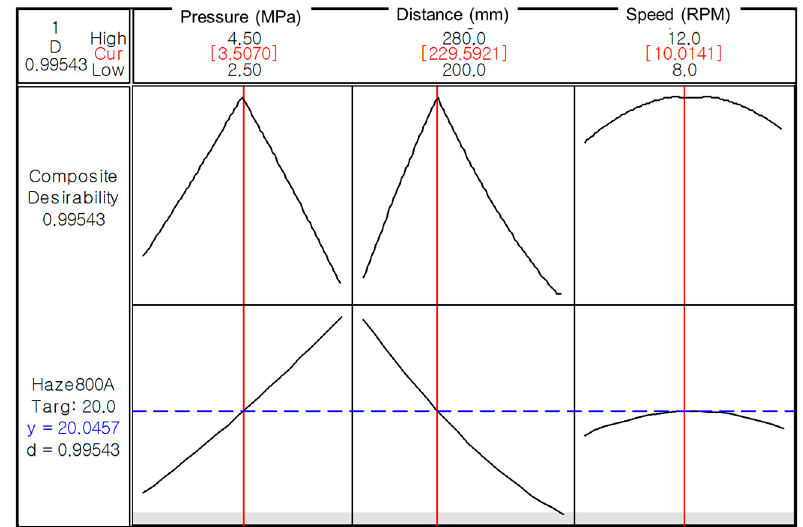
Figure 6. Optimization plot for haze target of 20%.